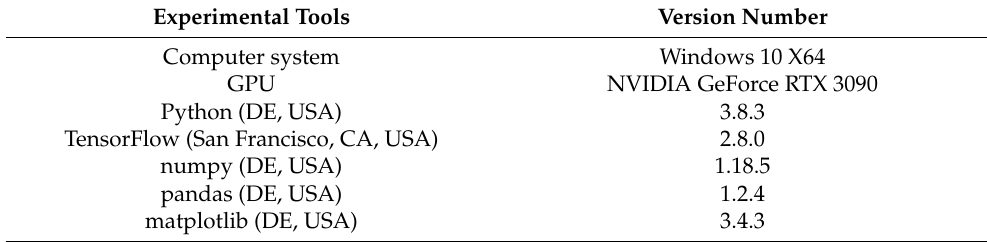
Table 5. Experimental environment.